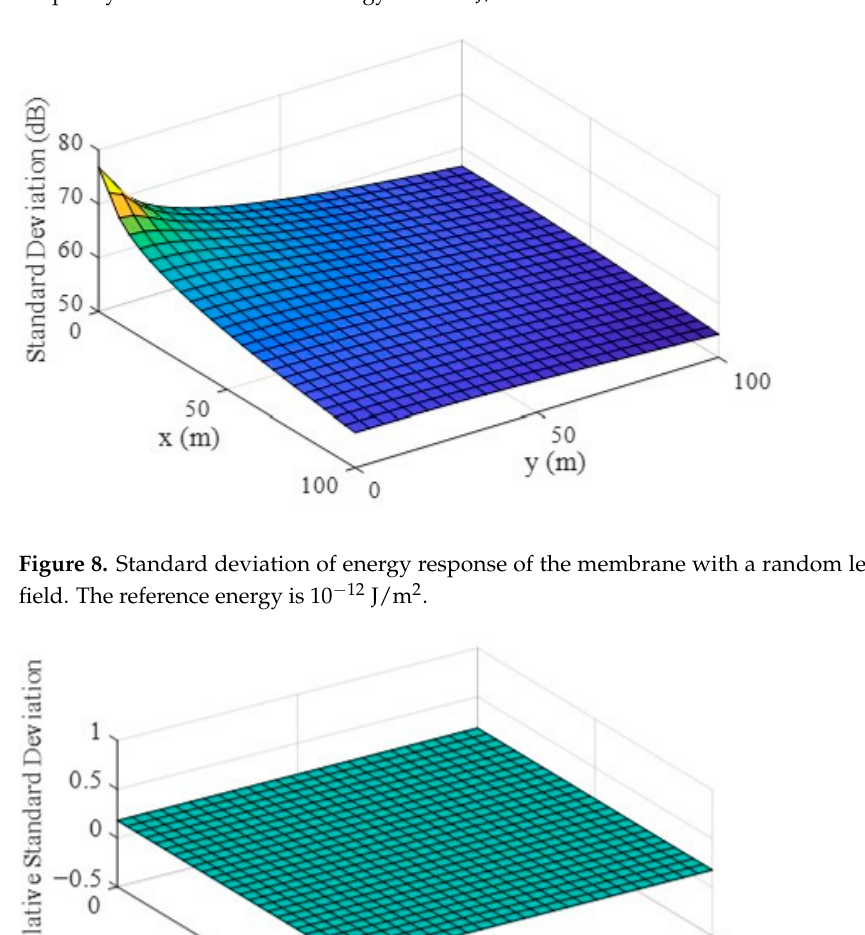
Figure 7. Relative standard deviations of energy response of the membrane with a random length in frequency field. The reference energy is 10 − 12 J/m 2 .